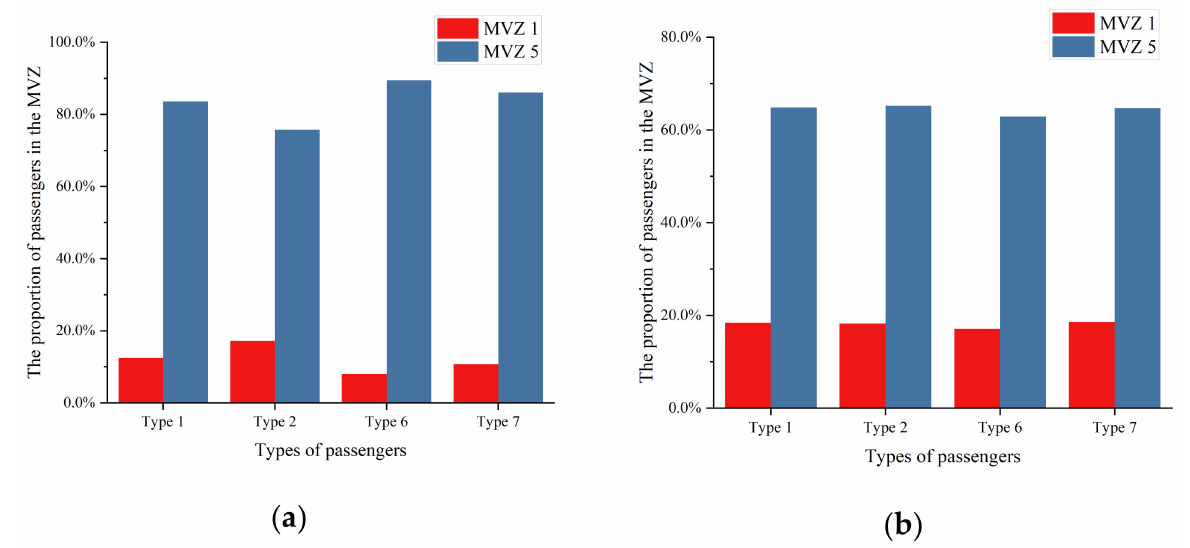
Figure 15. The MVZs of the last 10% of arriving passengers under night scenarios. ( a ) The night- individual scenario; ( b ) the night-group